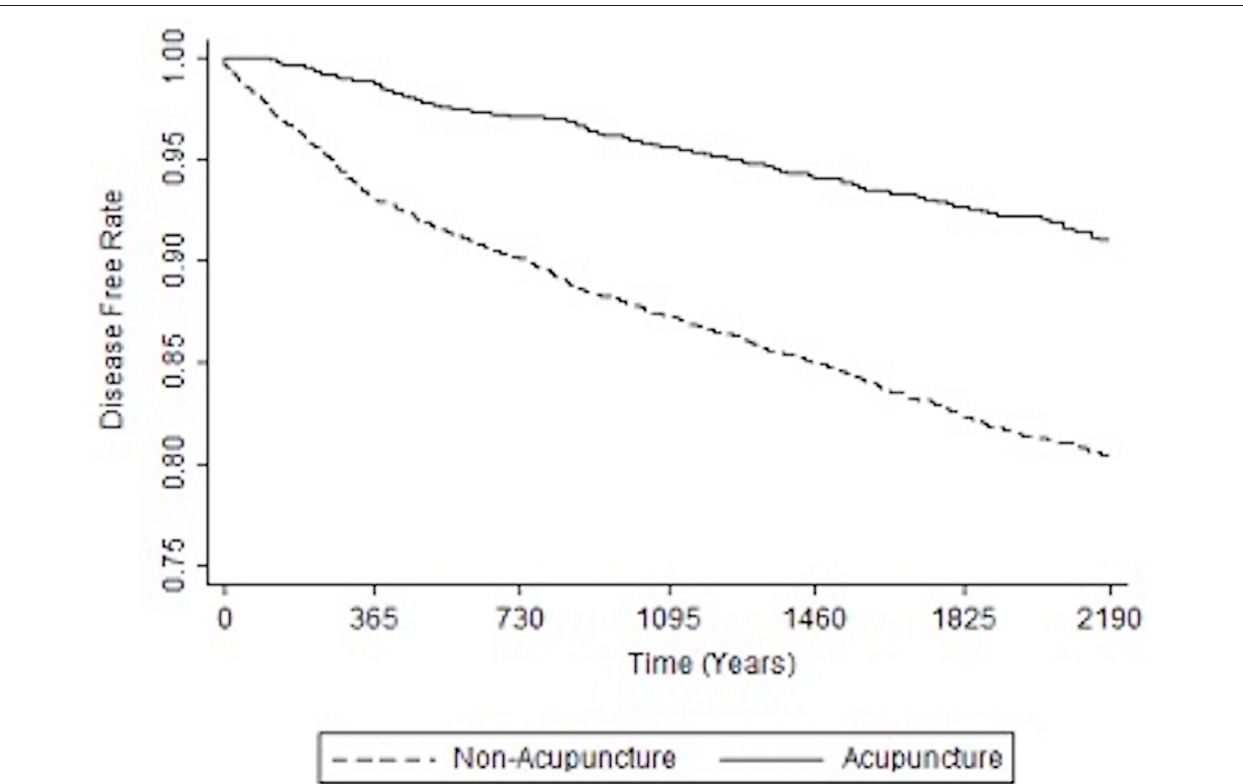
FIGURE 3 | Kaplan-Meier curve of the estimated dementia-free proportions of patients with stroke who received and did not receive acupuncture treatment.